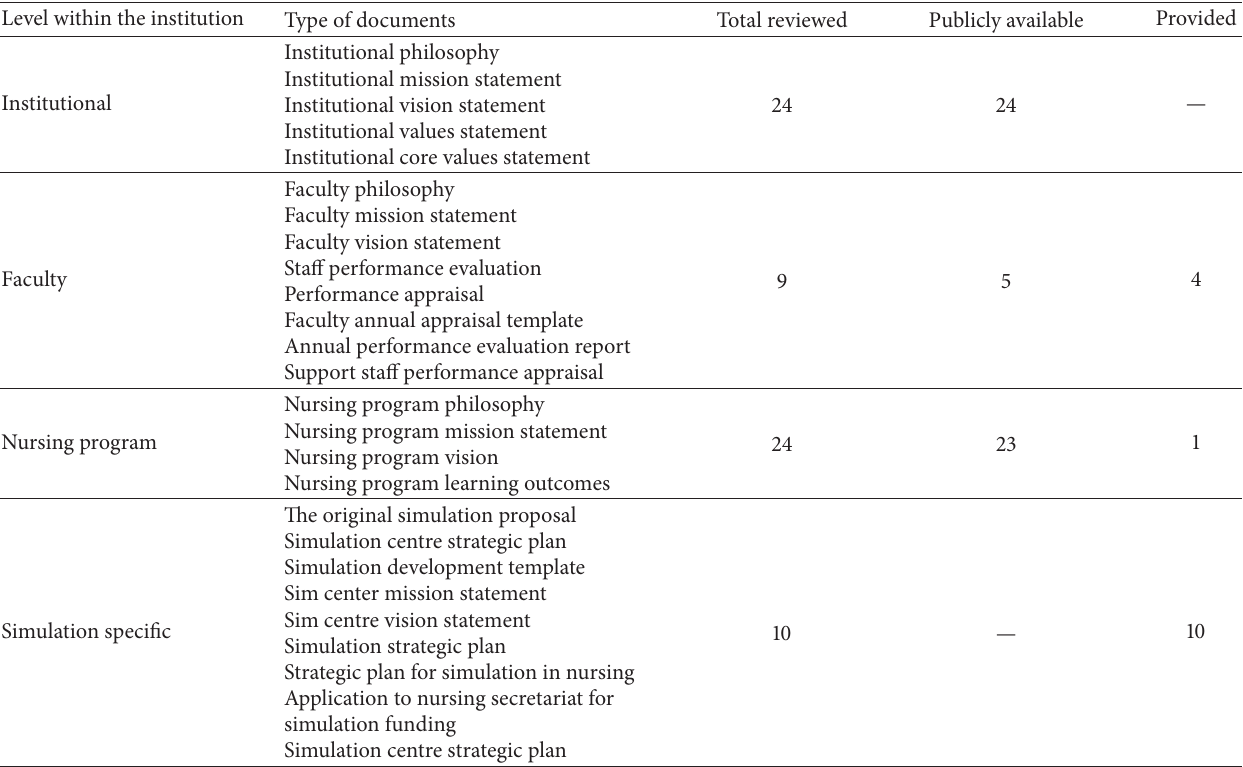
Table 2: Documents